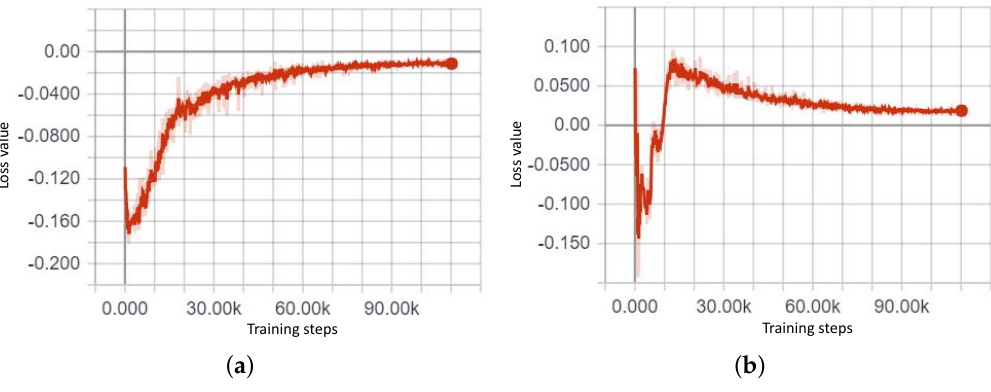
Figure 13. Losses of DCWGAN-GP. ( a ) Losses of the discriminator, and ( b ) losses of the